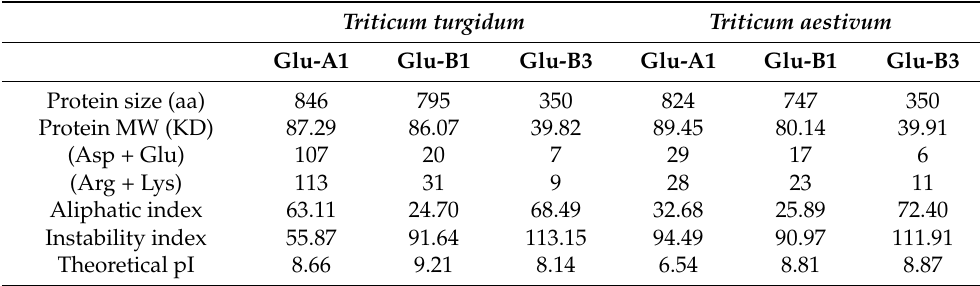
Table 7. The computed protein parameters: protein size, molecular weight, extinction coefficient, and atomic composition of Glu-A1, Glu-B1, and Glu-B3 of Triticum turgidum and Triticum aestivum